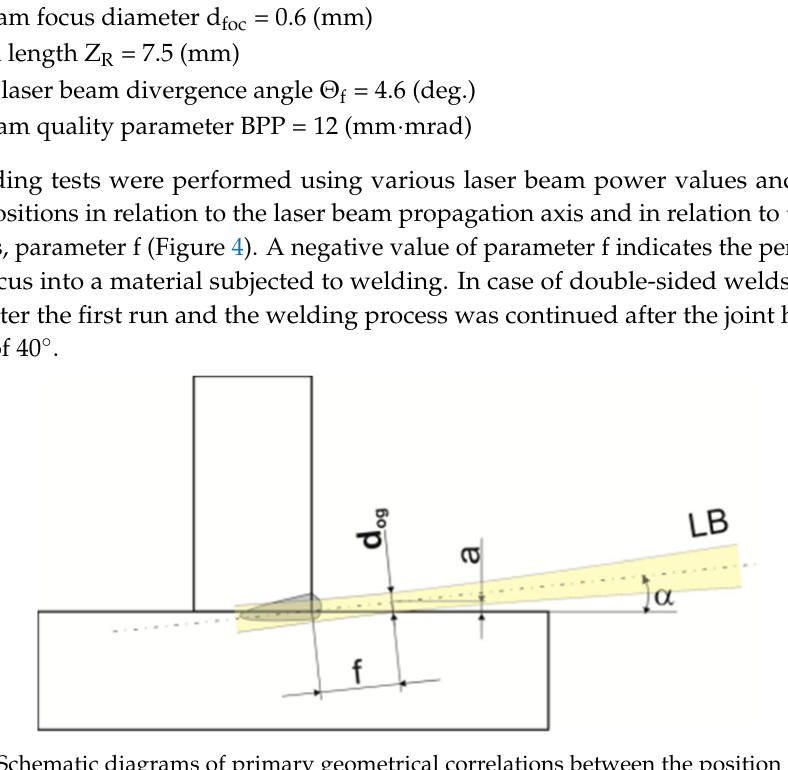
Figure 5. Maximum penetration during single ‐ sided welding.